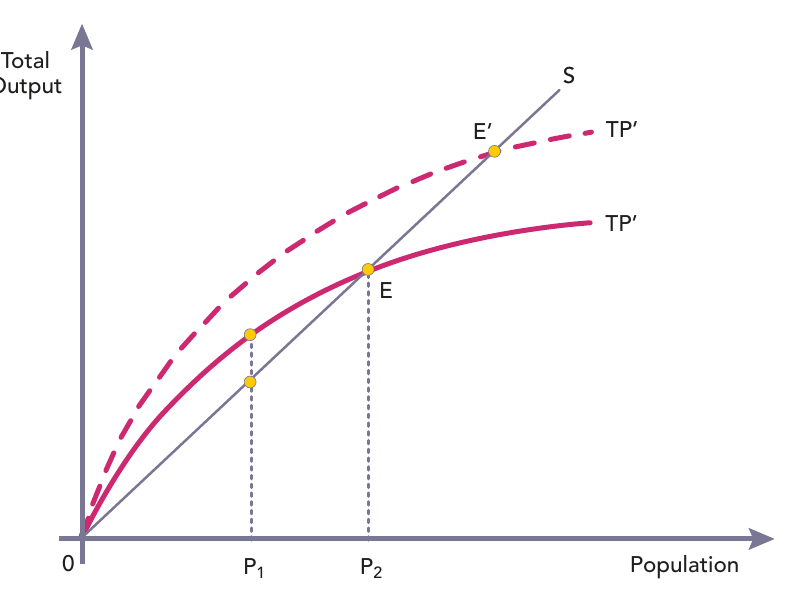
Figure 2. The magnificent